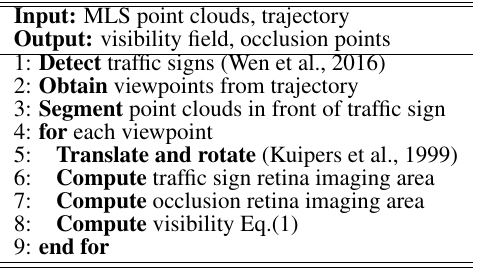
Table 1. The visibility evaluation algorithm of a traffic